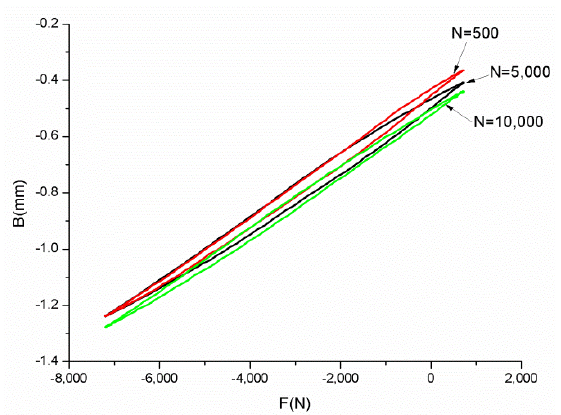
Figure 5. Hysteretic behavior of the tested aluminum foam sandwich.